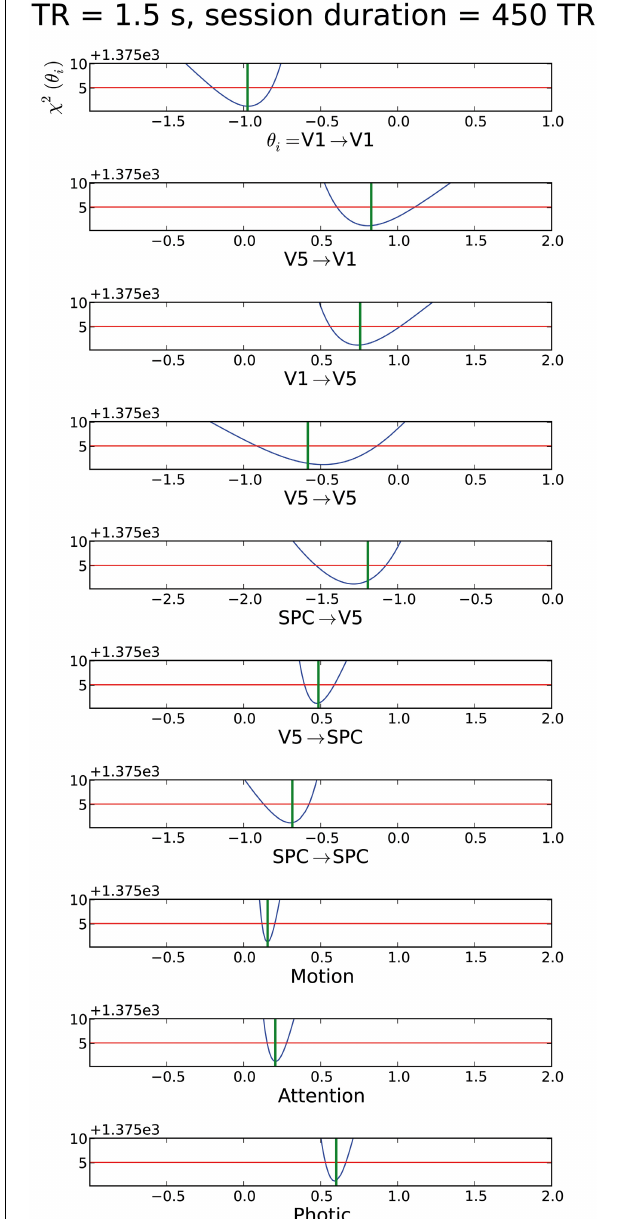
FIGURE 7 | Optimizing experimental design by manipulating two imaging specifications (here TR and session duration) at the same time, where mCI = 0.32. For further explanation of the graphs see Figure 2